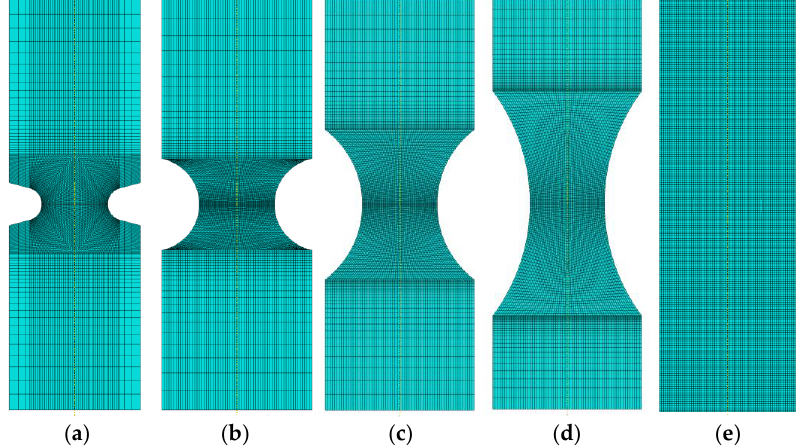
Figure 6. Geometry of the specimens tested in the program. R = 1.0 ( a ), R = 2.5 ( b ), R = 5.0 ( c ), R = 10.0 ( d ), smooth round ( e ). R = 10.0 ( d ), smooth round ( e ).